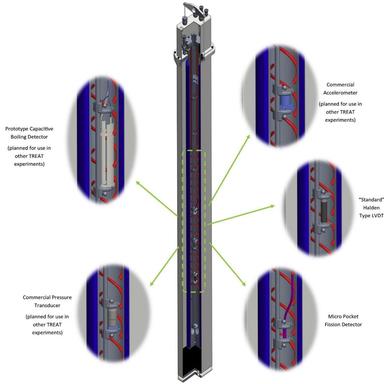
Example Instruments using MIMIC in Heater Module.